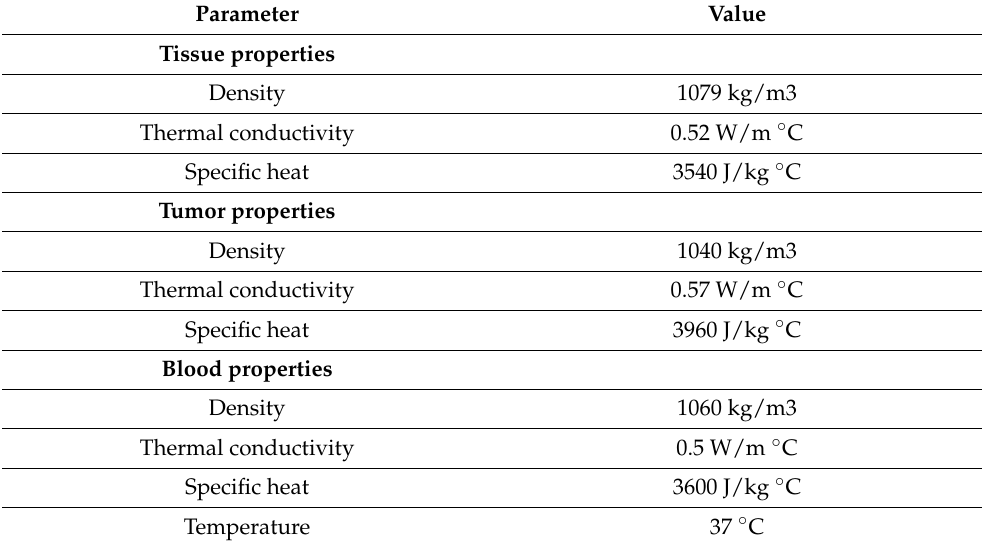
Table 1. The parameters of biological materials (healthy liver tissue, tumoral liver tissue, and blood) were collected from the literature [68] and used in numerical